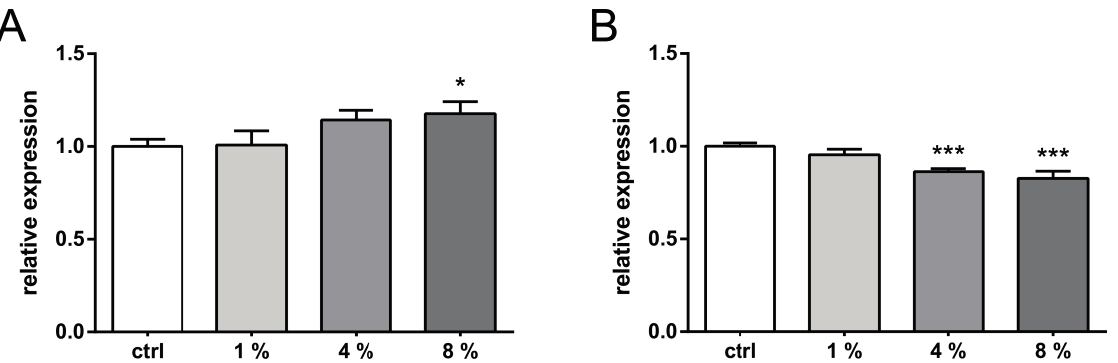
Figure 5. Stretch dependency of sVEGFR-1 expression in C-28/I2. Cells were stretched for 12 h with cyclic waveforms and a variety of relative strains. Expression of soluble decoy VEGF receptor: sVEGFR-1 was analyzed directly after straining ( t post straining ( B ), using cyclic square waveform at 0.5 Hz. Relative percentages of stretching are indicated ( i.e. , 1%, 4% or 8%, respectively). Unstrained controls (ctrl) were used to normalize data (set to 1). * and *** indicate significance levels of p ≤ 0.05 and p ≤ 0.001 respectively, n =